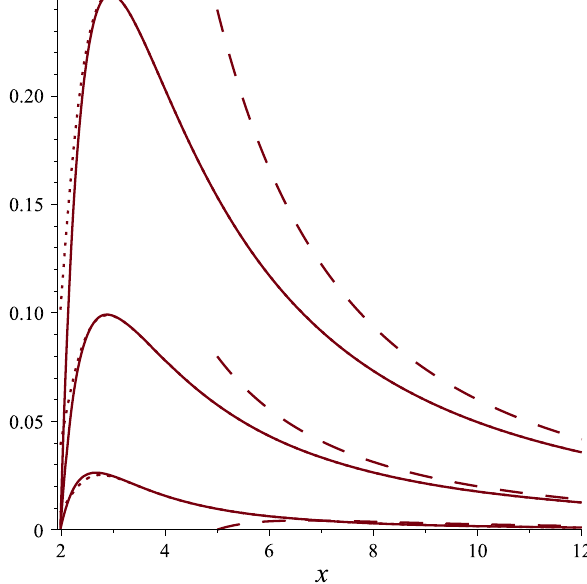
Fig. 2 Plot of the effective potential U ef f in the case of an extreme (dotted line )and a non extreme noncommutative geometry inspired Schwarzschild black hole (solid line) for different values of the angular momentum ( (cid:3) = 0 bottom, (cid:3) = 1 middle, (cid:3) = 2 upper potential curve). The dashed line patterns represent the asymptotic approximations (19) and (20). Approximation (19) loses precision as (cid:3)